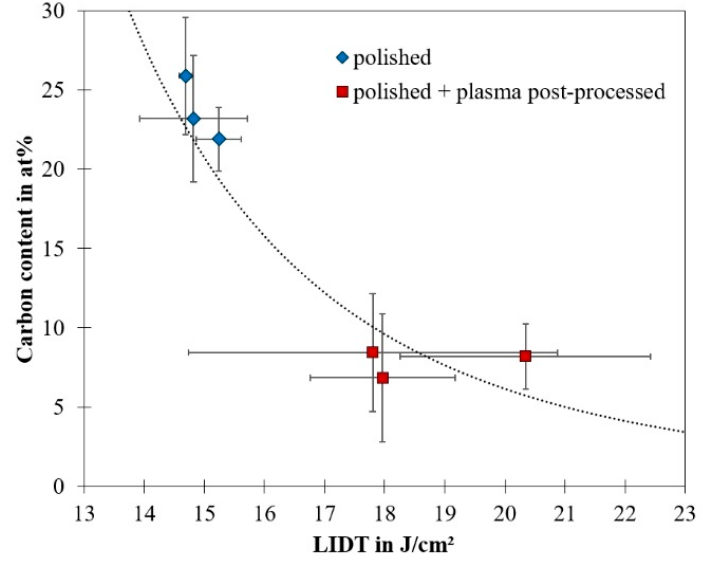
Figure 7. Correlation of the carbon content and the laser-induced damage threshold (LIDT) of polished zinc crown glass samples with and without plasma post-processing including general trend (dotted